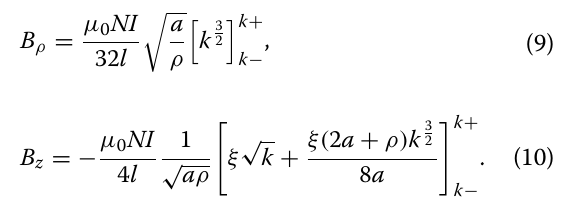
scale. Further, in the process of optimizing the coil configu- ration described in Section 3, normalized values of optimi- zation operators are used for convenience of comparison, which eliminated the whole-scale truncation errors and did not affect the design and optimization result described in Section 3.